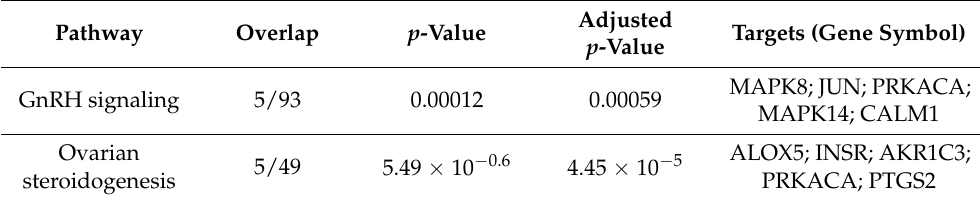
Table 2. Significant enrichment pathways and their target genes related to the therapeutic effect of APE on